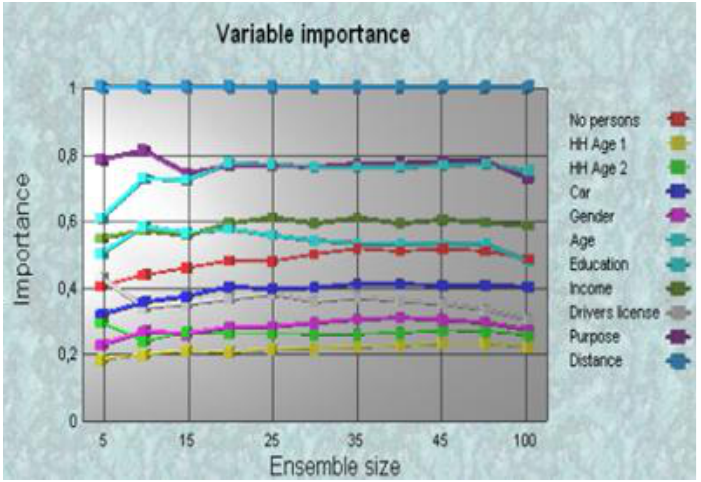
Figure 6: Relationship between ensemble size and variable